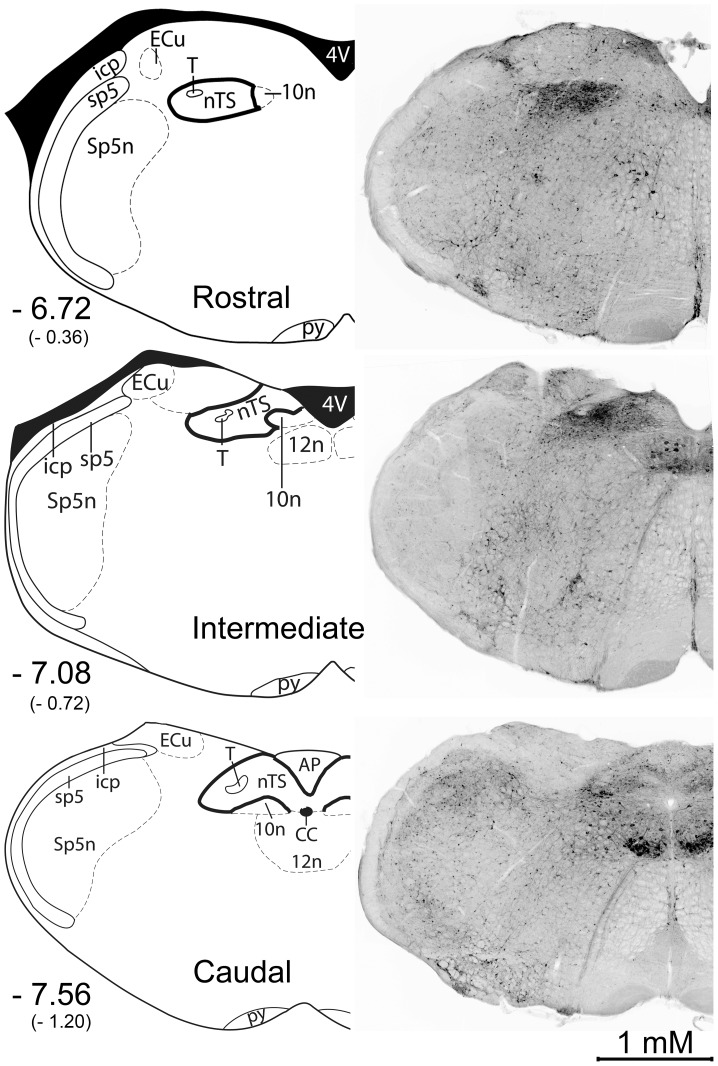
β – galactosidase staining is found throughout the brainstem, but is especially dense within the nTS and hypoglossal nucleus.
Left: Three rostrocaudal nTS levels designated as Rostral, Intermediate, and Caudal. Coordinates from Bregma are listed for each nTS level. Numbers in parenthesis represent coordinates relative to the rostral-most (i.e. ‘r1’) portion of the nTS as defined previously [17]. AP: area postrema, CC: central canal, ECu: external cuneate nucleus, icp: inferior peduncle, nTS: nucleus of the solitary tract, py: pyramidal tract, sp5: spinal trigeminal tract, Sp5n: spinal trigeminal nucleus, T: solitary tract, 4V: 4th ventricle, 10n: dorsal motor nucleus of the vagus, 12n: hypoglossal nucleus. Images modified from Paxinos The Mouse Brain in Stereotaxic Coordinates, 2nd Edition. Right: Photomicrographs of fluorescent β – galactosidase staining in the brainstem of a FTL mouse that received no stimulation (Unstim) Images converted to greyscale colors for clarity.